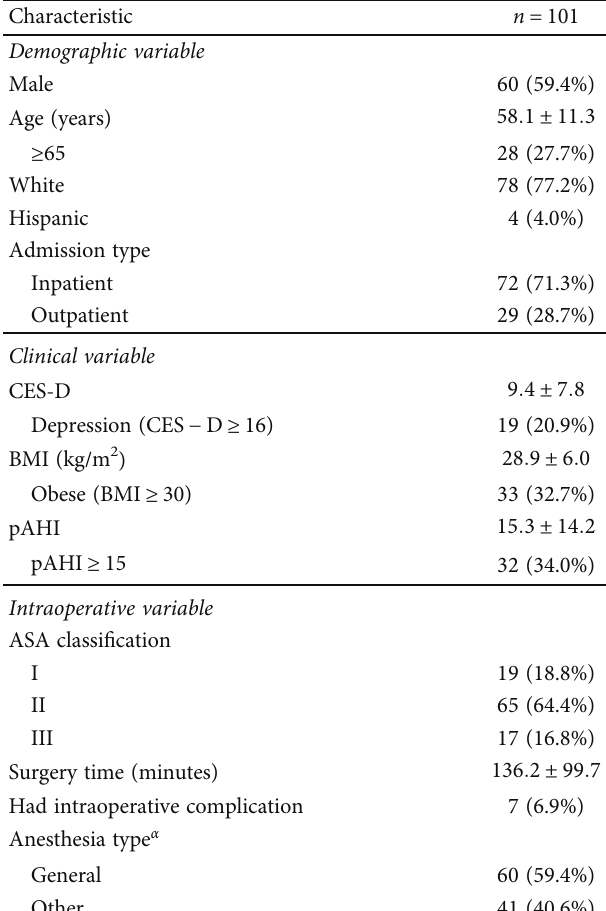
Table 1: Demographic and clinical variables at baseline and intraoperative